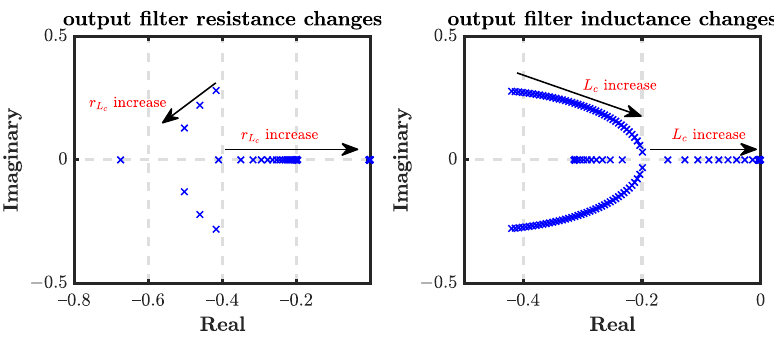
≤ 10 Ω and 0.35mH ≤ L c ≤ c